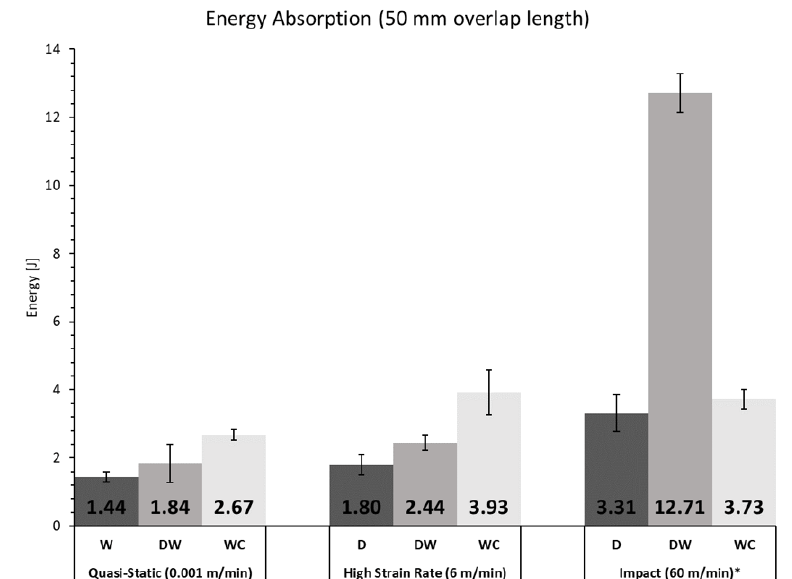
Figure 23. Summary of the energy absorption values for each configuration and cross-head rate (* For DW 120 m/min are considered since the joint did not break for 60 m/min).